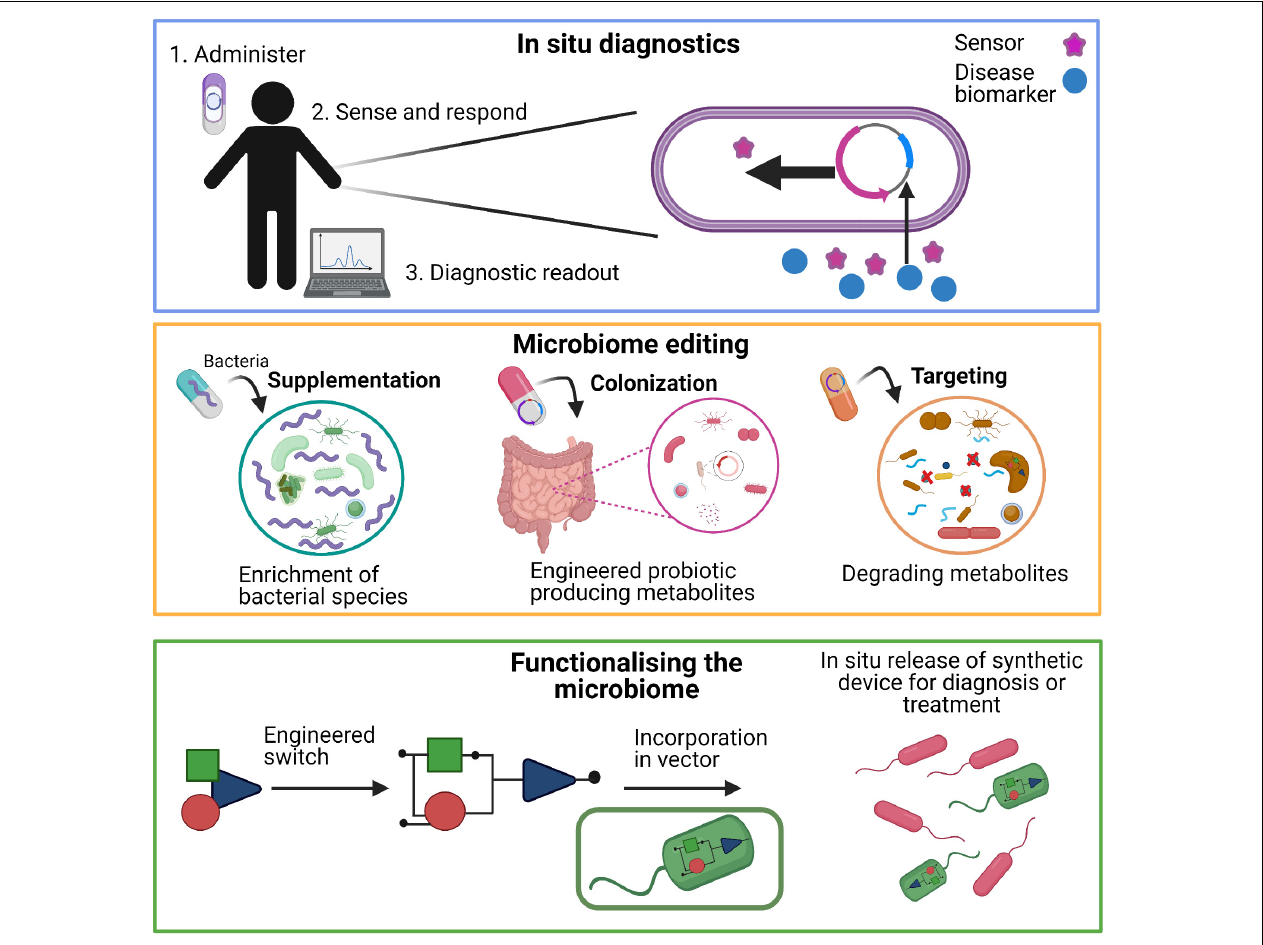
FIGURE 3 | The design-build-test learn cycle (DBTL cycle) for integrating multi-omics data to infer detailed biological insight for designing new diagnostic and therapeutics for personalized and translational medicine. Different omics datasets can be generated from high-throughput studies and enables the characterization of cells and/or tissues in health and disease states. A combination of omics is necessary to reveal the complex behavior of cells and/or tissues that are present in different states. Integrating these high throughput omics data with systems biology methods such as genome-scale metabolic models can lead to more in depth biological knowledge revealing molecular mechanisms involved in health and disease states. Using synthetic biology, different engineering strategies can be employed to construct an organism that performs the desired